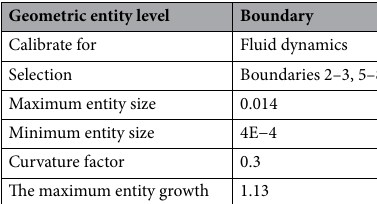
Table 3. Elaboration of mesh size.